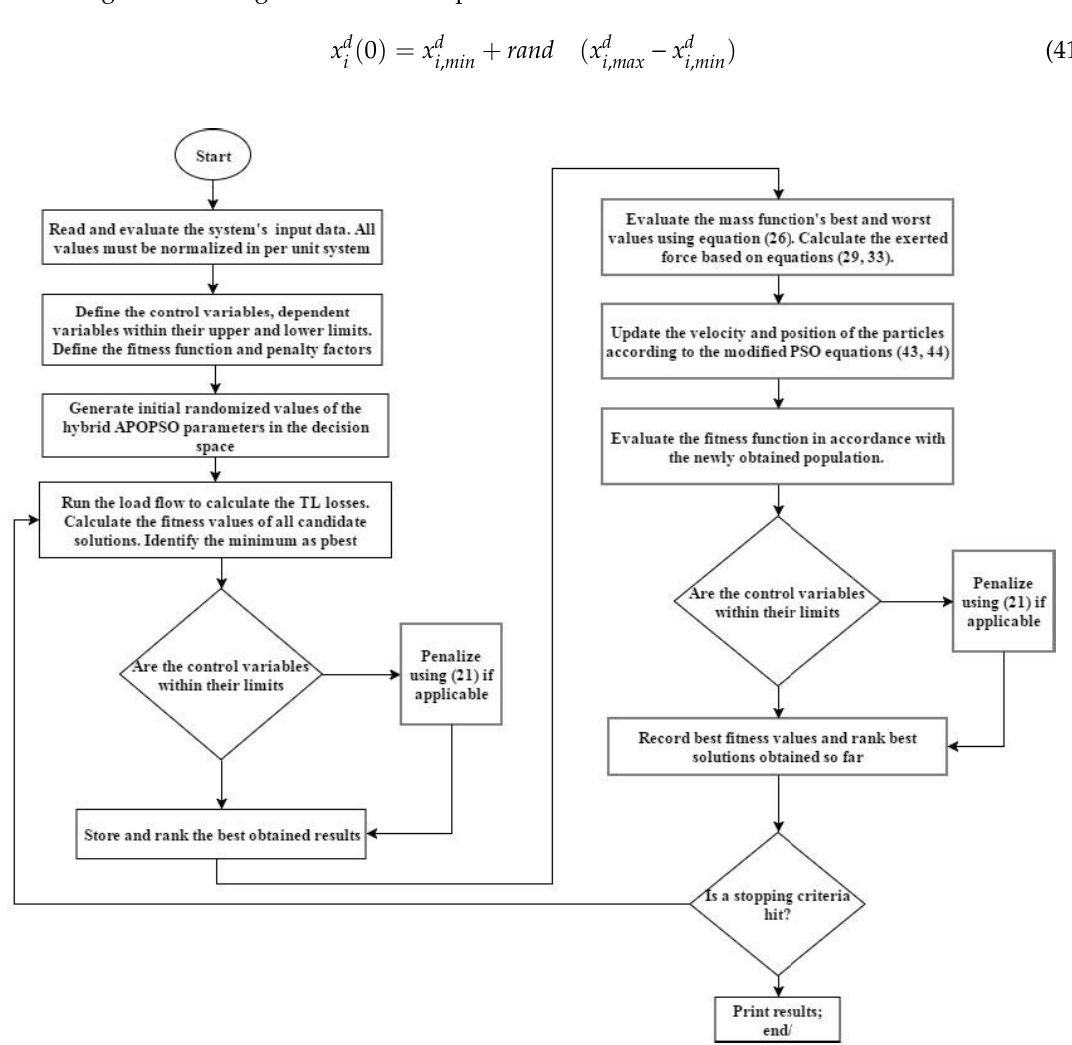
Figure 2. The proposed algorithm to solve the optimal reactive power dispatch (ORPD) problem.